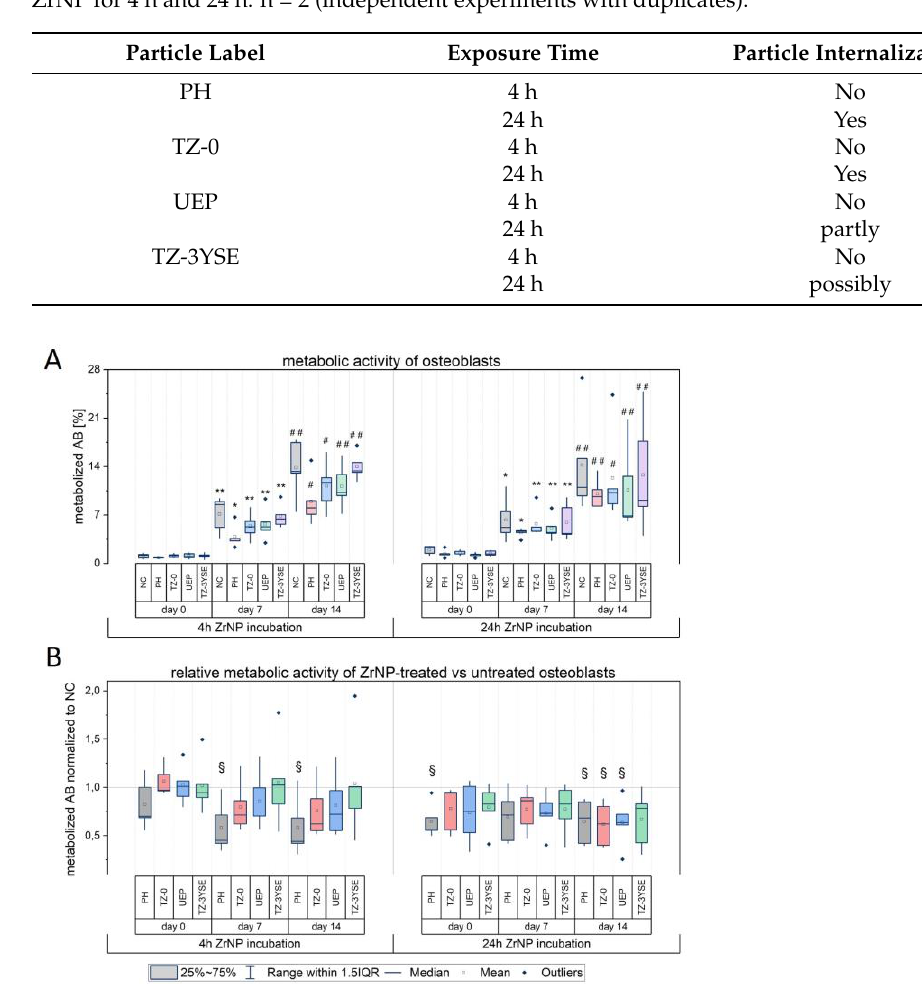
Figure 5. ( A ) Metabolic activity of osteoblasts determined by the amount of metabolized alamarBlue (AB) reporter dye product in the supernatant at day 0, 7 and 14 of culture. Day 0 indicates the AB metabolization directly after incubation. The AB metabolization rate is given as percentage of a 100% reduced medium control according to the manufacturer. ( B ) Relative metabolic activity of ZrNP treated and untreated cells. A +ZrNP/-ZrNP ratio of 1 means no effect, i.e., AB metabolization in ZrNP-treated cells is equal to untreated cells. * p < 0.05 and ** p < 0.01 for comparison of AB metabolization at day 7 versus day 0; # p < 0.05 and ## p < 0.01 for comparison of AB metabolization at day 14 versus day 7; § p < 0.05 for comparison of AB metabolization between ZrNP-treated and untreated cells (NC); Paired t -test, n = 5.